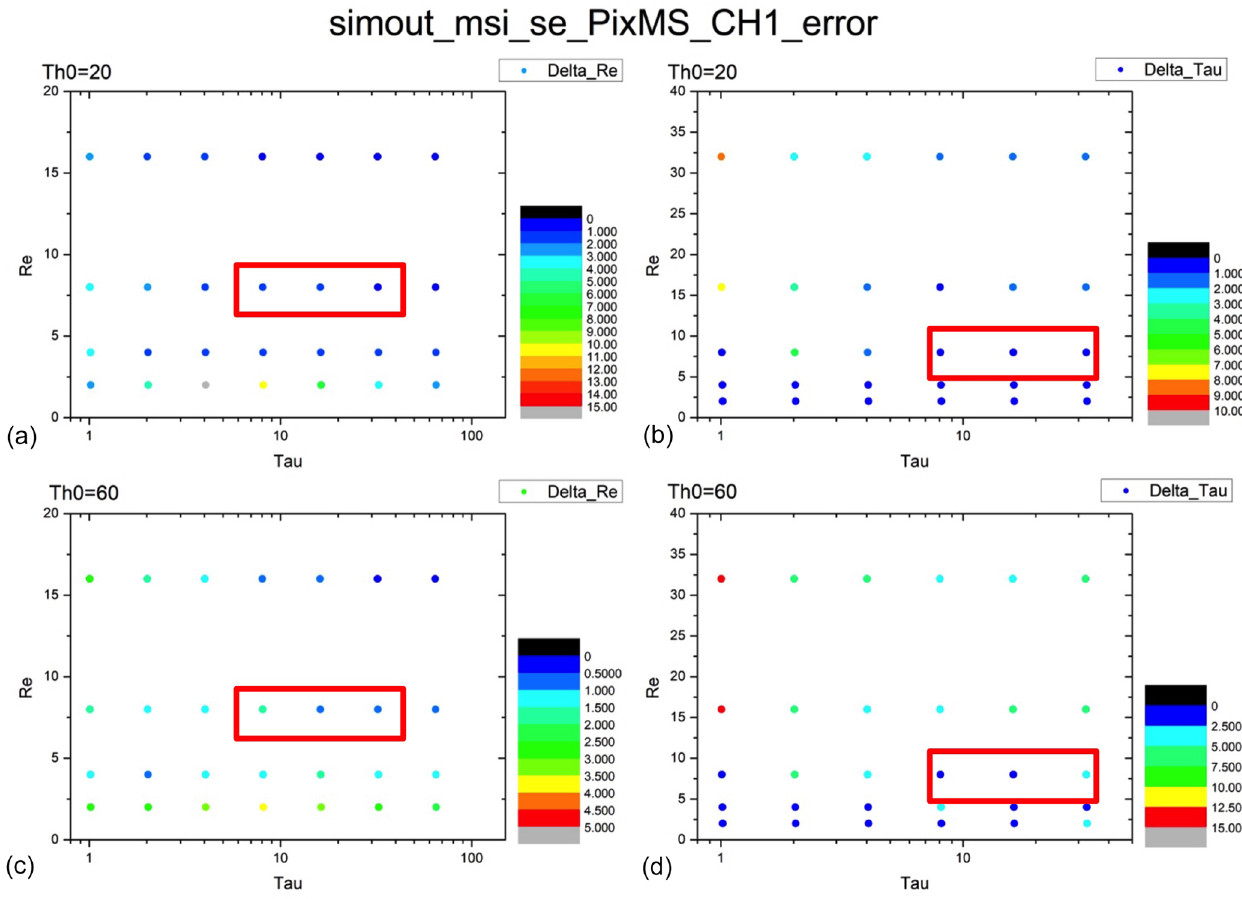
Figure 7. Error distributions of COT and CDR from the Nakajima–King diagram for shallow warm clouds at pix_BND1_min. (a) Distribution of (cid:49)r e for a solar zenith angle of 20 ◦ . (b) Distribution of (cid:49)τ for a solar zenith angle of 20 ◦ . (c) Distribution of (cid:49)r e for a solar zenith angle of 60 ◦ . (d) Distribution of (cid:49)τ for a solar zenith angle of 60 ◦ . The red frames indicate the presence of typical shallow warm cloud. COT = 8 or 32, CDR =